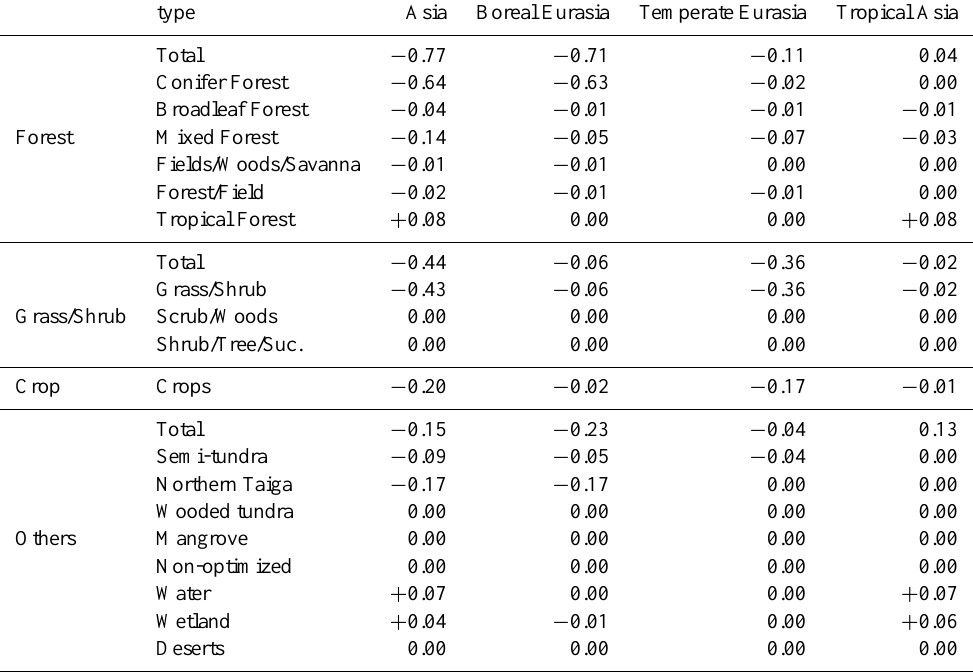
Table 4. The ecosystem-type associated posterior terrestrial biosphere fluxes for 2006–2010 (units ofPgCyr − 1 ) .